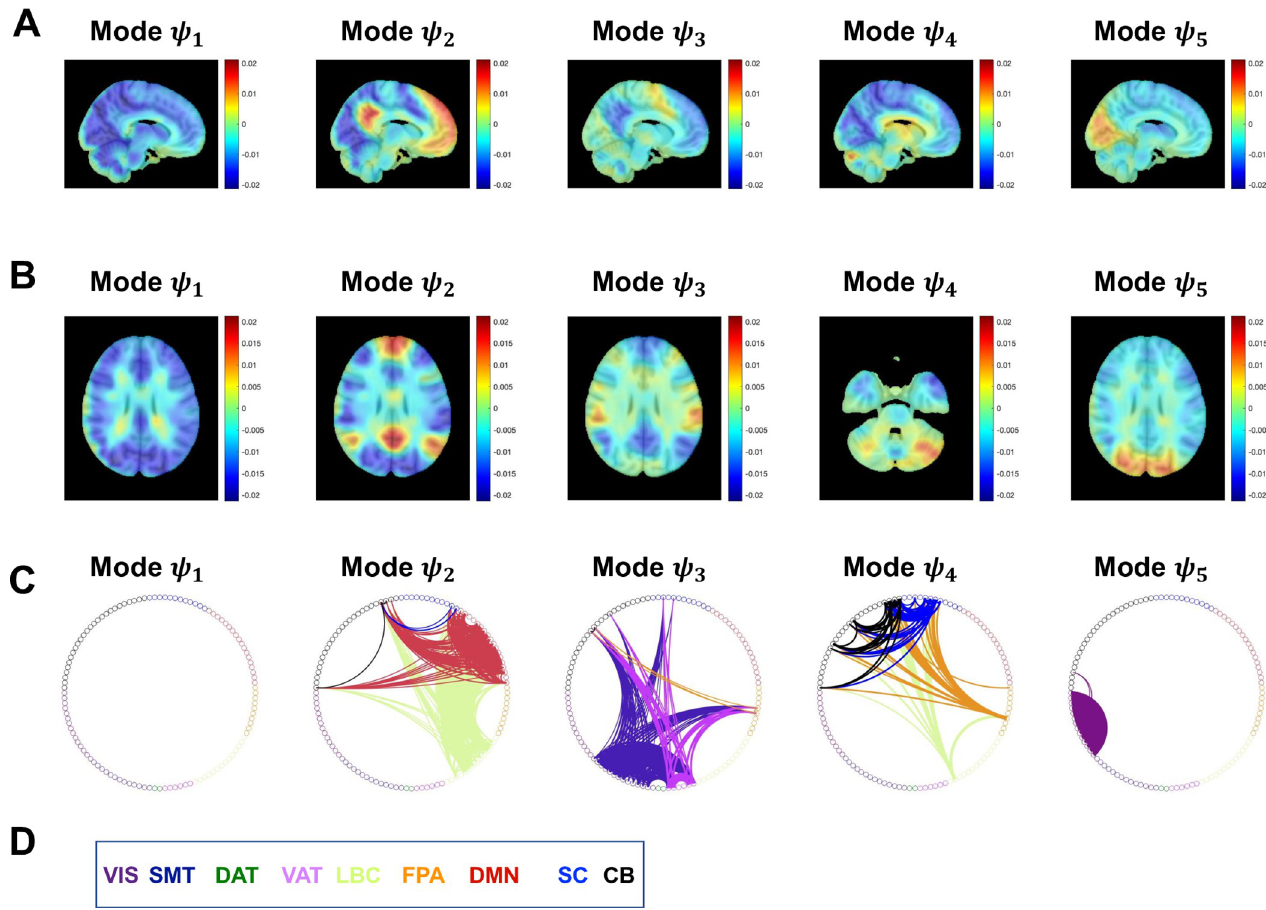
Fig 2. Spatial patterns of recurrent phase-locked connectivity in RUN3 for controls. A) Phase-locking patterns for the 5 modes in sagittal view. B) Phase- locking patterns for the 5 modes in axial view. C) Respective FC presented as connectograms color-coded as in Yeo [63] with the addition of dark blue for subcortical regions, and black for cerebellar regions. In Mode ψ 1 all regions are aligned in-phase and so there is no antiphase connectivity. FC computed as the outer product of the leading eigenvector for each mode. D) Color coded legend for the Yeo resting-state networks, subcortical and cerebellar regions. VIS, Visual; SMT, Somatomotor; DAT, Dorsal attention; VAT, Ventral attention; LBC, Limbic; FPA, Frontal parietal; DMN, Default mode network; SC, Subcortical; CB, Cerebellar.